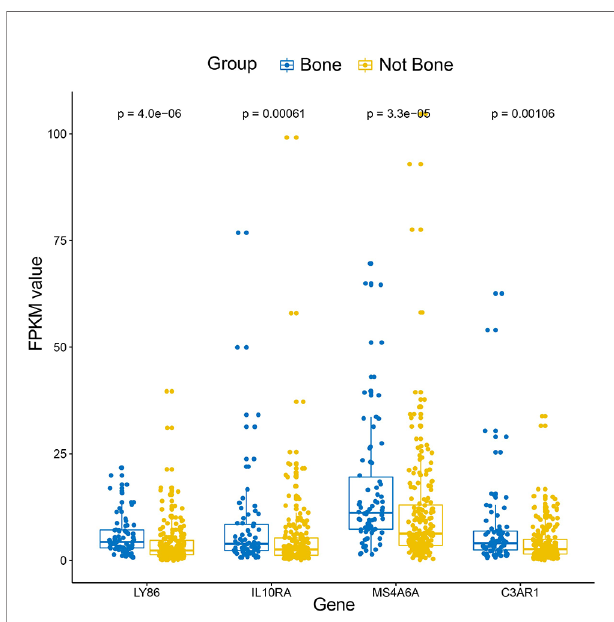
FIGURE 7 | Box-plot of expression values (FPKM) of the four hub genes between bone and non-bone tissues in the metastatic CRPC patients derived from Abida W ’ s study.